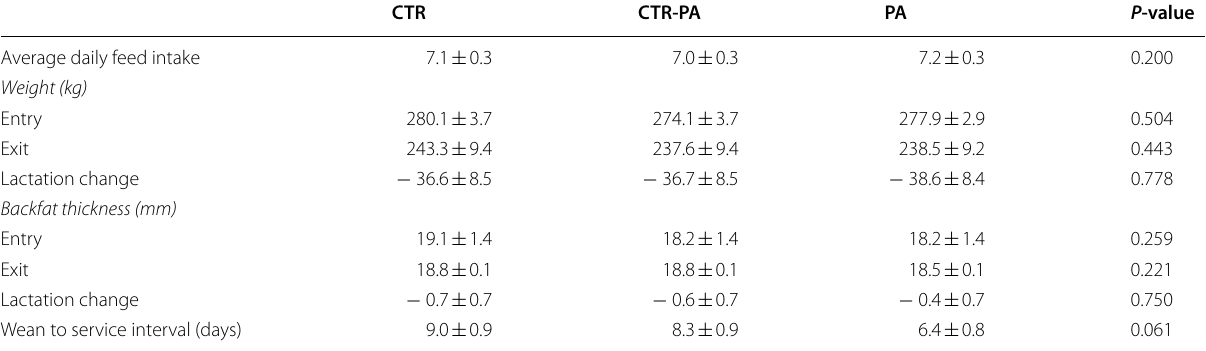
All data are expressed as mean